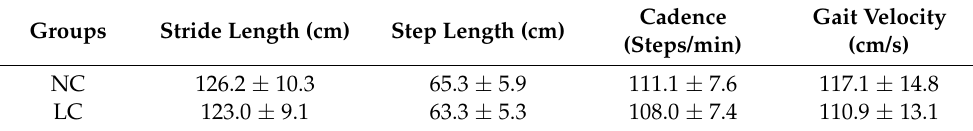
Cadence (Steps/min)